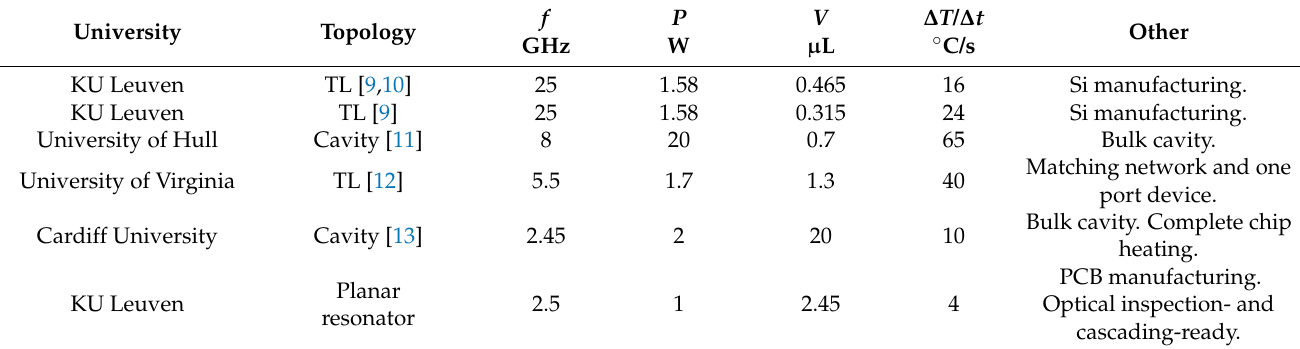
Table 1. State-of-the-art summary of microwave heaters for